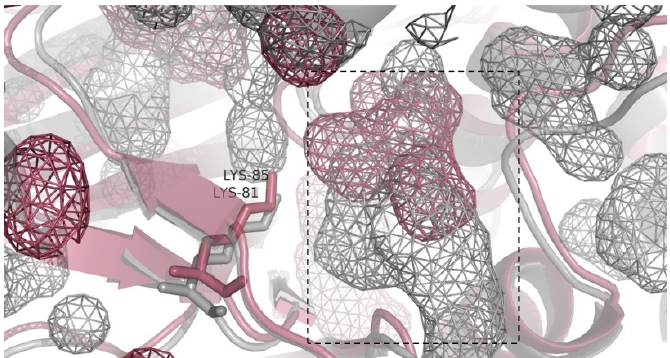
Figure 5. Active site pocket area for the apo-, indole-, and 3-bromoindole-docked SpH2 and SpH1 halogenases, showing the flexibility of SpH2 in accommodating 3-bromoindole, unlike SpH1.